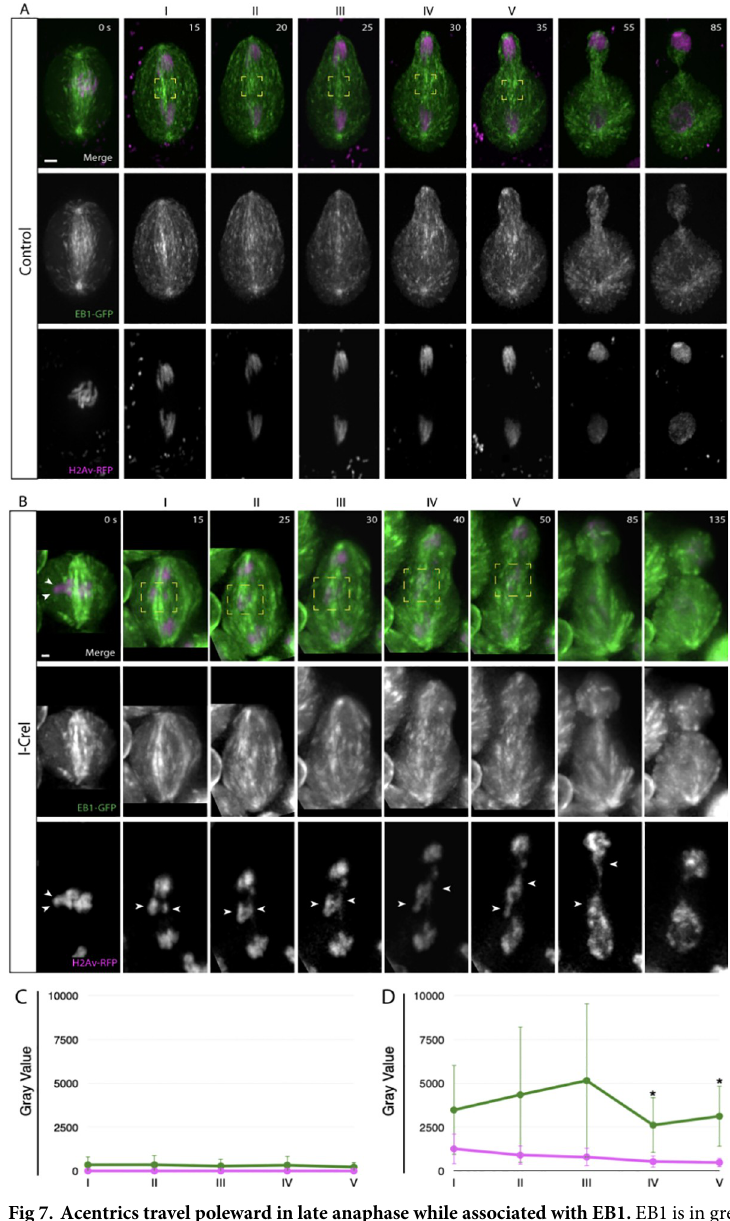
Fig 7. Acentrics travel poleward in late anaphase while associated with EB1. EB1 is in green and chromosomes are in magenta. (A) Still images from a time-lapse movie of a control neuroblast from metaphase (0 s) through telophase (85 s). (B) Still images from a time-lapse movie of a mitotic neuroblast with I-CreI induced acentrics from metaphase (0 s) through telophase (135 s) (S5 Data). The intact chromosomes and acentrics initiate sister separation at the 15 s and 40 s timepoints, respectively. Sister acentrics (white arrowheads) separate and move toward opposite cell poles while associated with EB1. (C) Line graph from a compilation of five control videos showing the corrected fluorescence intensities in arbitrary units (AU) of EB1 (green) and chromosomes (magenta). Corrected fluorescence intensities were calculated within the yellow boxes at the time points 15, 20, 25, 30, 35 seconds after anaphase onset. (D) Line graph from a compilation of five videos of I-CreI-expressing neuroblasts showing the corrected fluorescence intensities in arbitrary units (AU) of EB1 (green) and chromosomes (magenta). Corrected fluorescence intensities were calculated within the yellow boxes at the time points 15, 25, 30, 40, 50 seconds after anaphase. Bars, 2 μ m. Time in seconds. Error bars represent SDs of the fluorescent intensities at all points